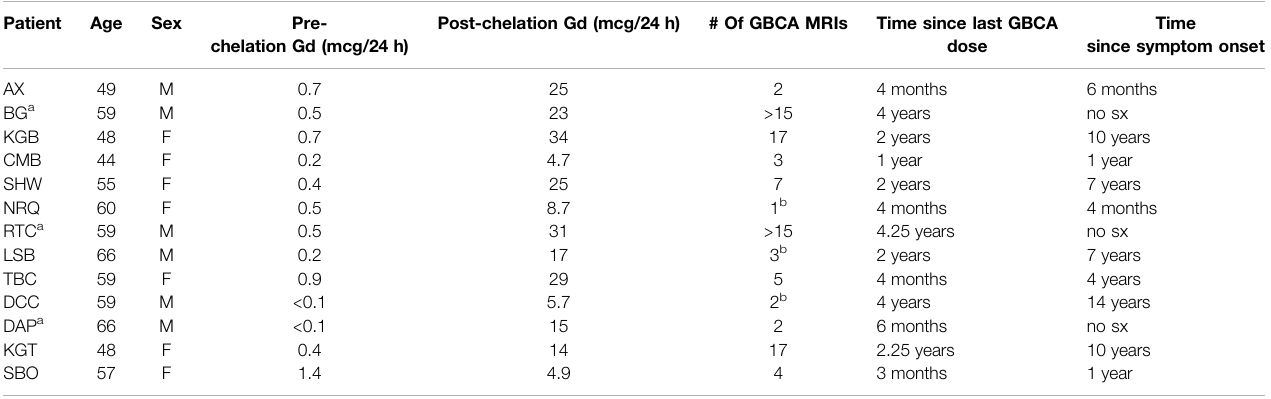
TABLE 1 | Patient clinical